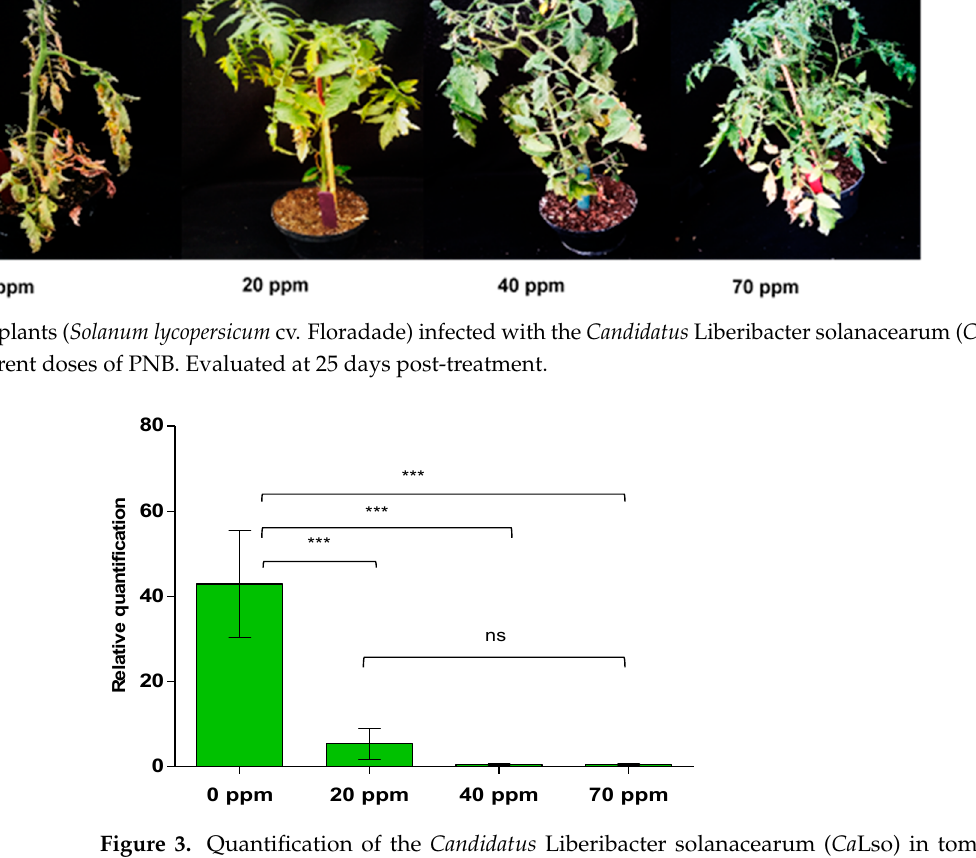
Figure 3. Quantification of the Candidatus Liberibacter solanacearum ( Ca Lso) in tomato leaves ( Solanum lycopersicum ) using qPCR. Differences were detected in three dose levels of PNB (i.e., dispersions containing 20, 40, and 70 ppm of PNB). Values are means ± SE ( n = 9). Level of significance: ***, p < 0.001; ns, no significance. One-way ANOVA, Tukey’s multiple comparison test at p = < 0.05.